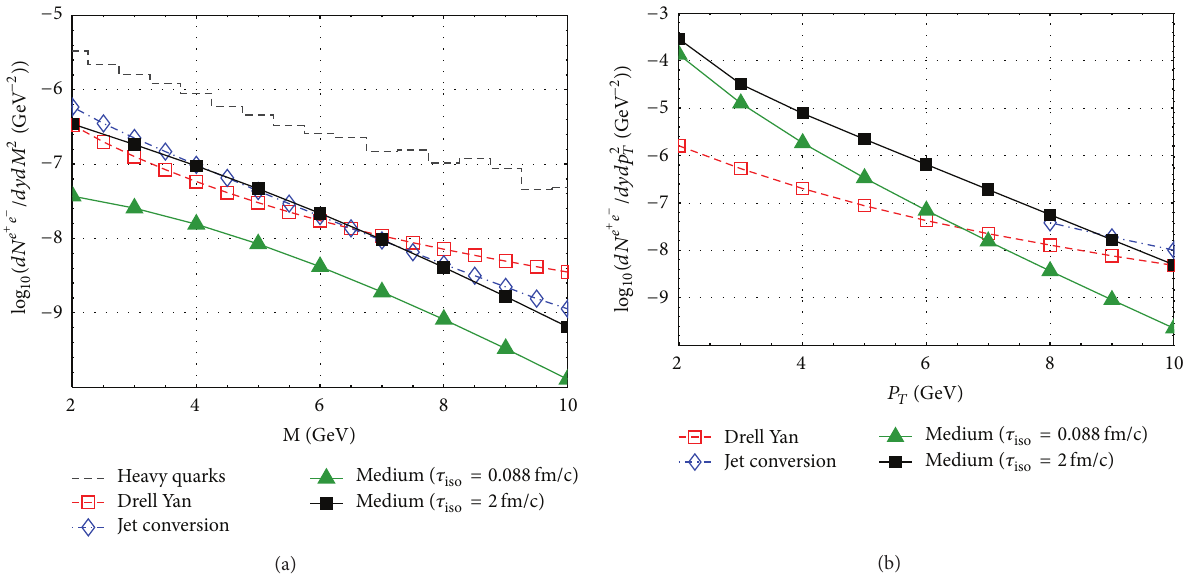
Figure 3: (Color online) Invariant mass (a) and momentum (b) distribution of midrapidity dileptons in central Pb + Pb collisions at LHC. The figures are taken from